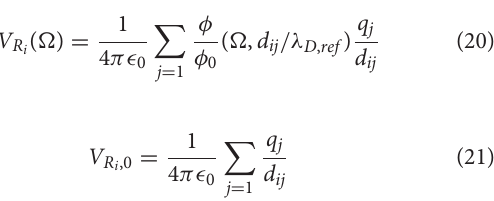
FIGURE 4 | Radiated electrostatic potential compared to the distance to the transmitter normalized by λ D , ref for (cid:127) with the real part (first line) and the imaginary part (second line) in a two-electron temperature plasma ( µ halo kappa evdf (here κ 2,7,24) and (ii) a sum of two Maxwellian evdf (blue =